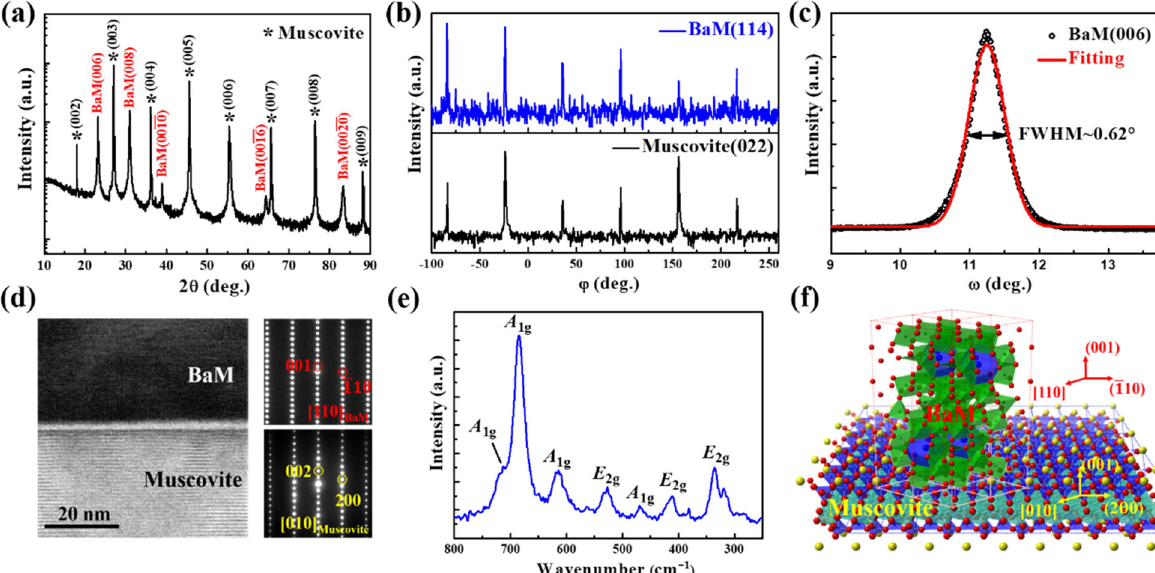
Fig. 1 Structural analyses of the BaM/muscovite heteroepitaxy. a Out-of-plane XRD 2 θ - θ scan. b Phi scans of BaM(114) and muscovite(022) re fl ections. c Rocking curve of BaM(006) peak. d Cross-sectional TEM image and corresponding selected area electron diffraction patterns. e Raman spectrum with the feature of A 1g and E 2g modes. f Schematic of the epitaxial relationship of BaM fi lm and muscovite